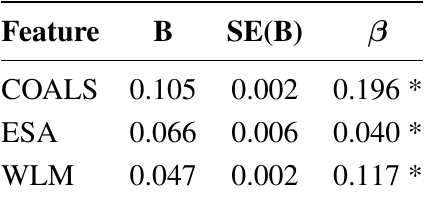
Table 12. Regression of COALS, ESA, and WLM raw scores on NMS similarity scores (N =